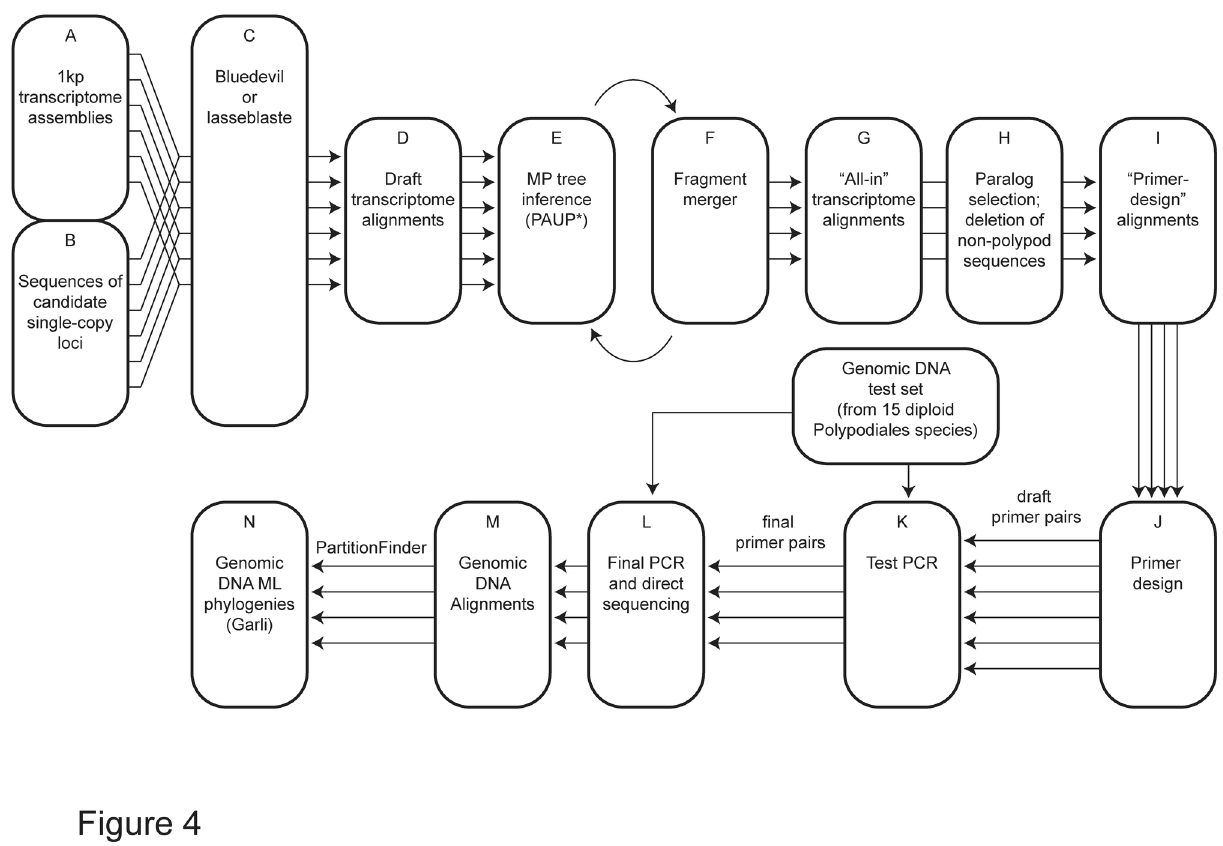
Figure 4. Flowchart of our transcriptome-mining